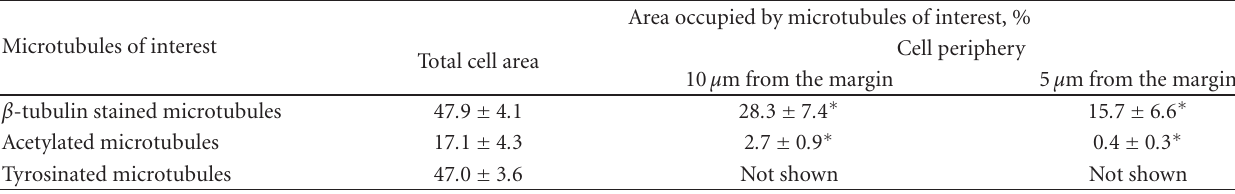
Table 1: Quantitative analysis of areas occupied by dynamic and stable microtubules in di ff erent compartments of human EC . Microtubules of